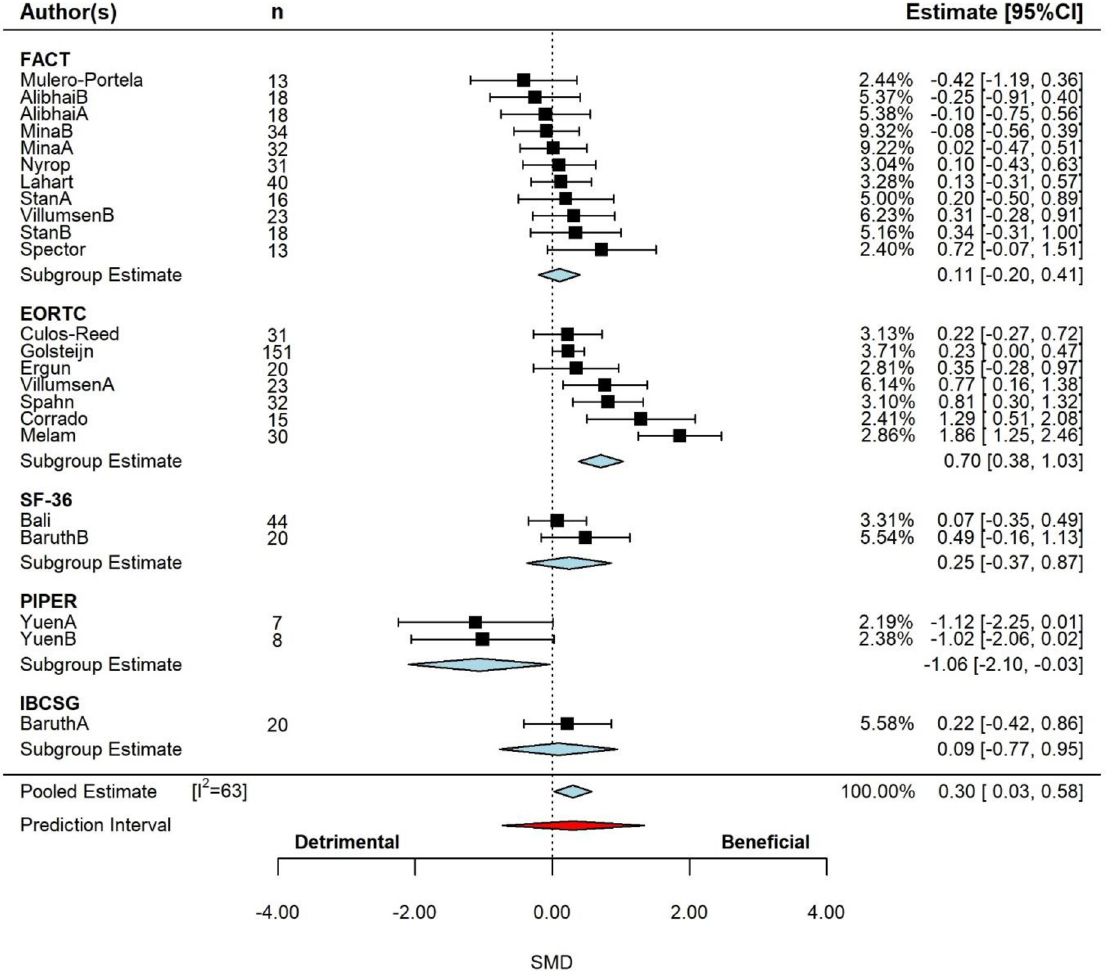
Fig 2. Pooled effect of exercise intervention on quality of life, with sub-group analysis by assessment type. (k = 17, u = 23, n = 508). Based on the 3-level model, there was a small but significant effect (SMD = 0.30, 95% CI: 0.01 to 0.60, p = 0.042). Abbreviations : CI, confidence interval; SMD, standardized mean